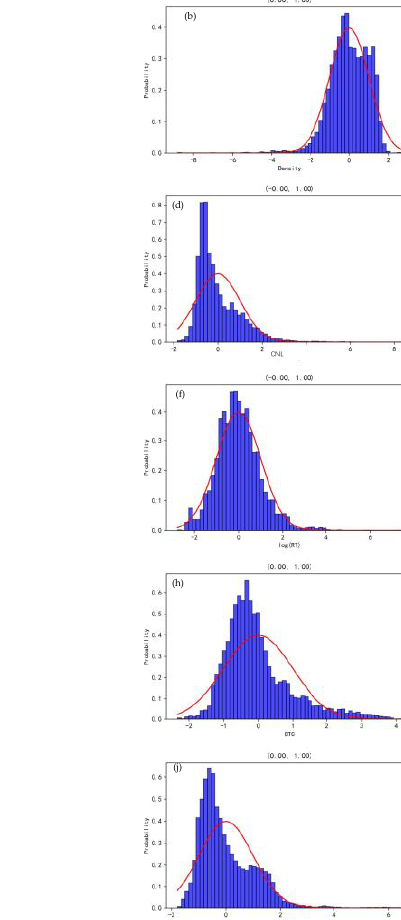
Figure 12. Comparison of statistical characteristics of feature curves before and after normalization. The sub-figures on the left side shows the logs before normalization ( a ) Density, ( c ) CNL, ( e ) log(RT), ( g ) DTC, ( i ) GR. Whereas, the subfigures on the right side shows logs after normalization ( b ) Den-